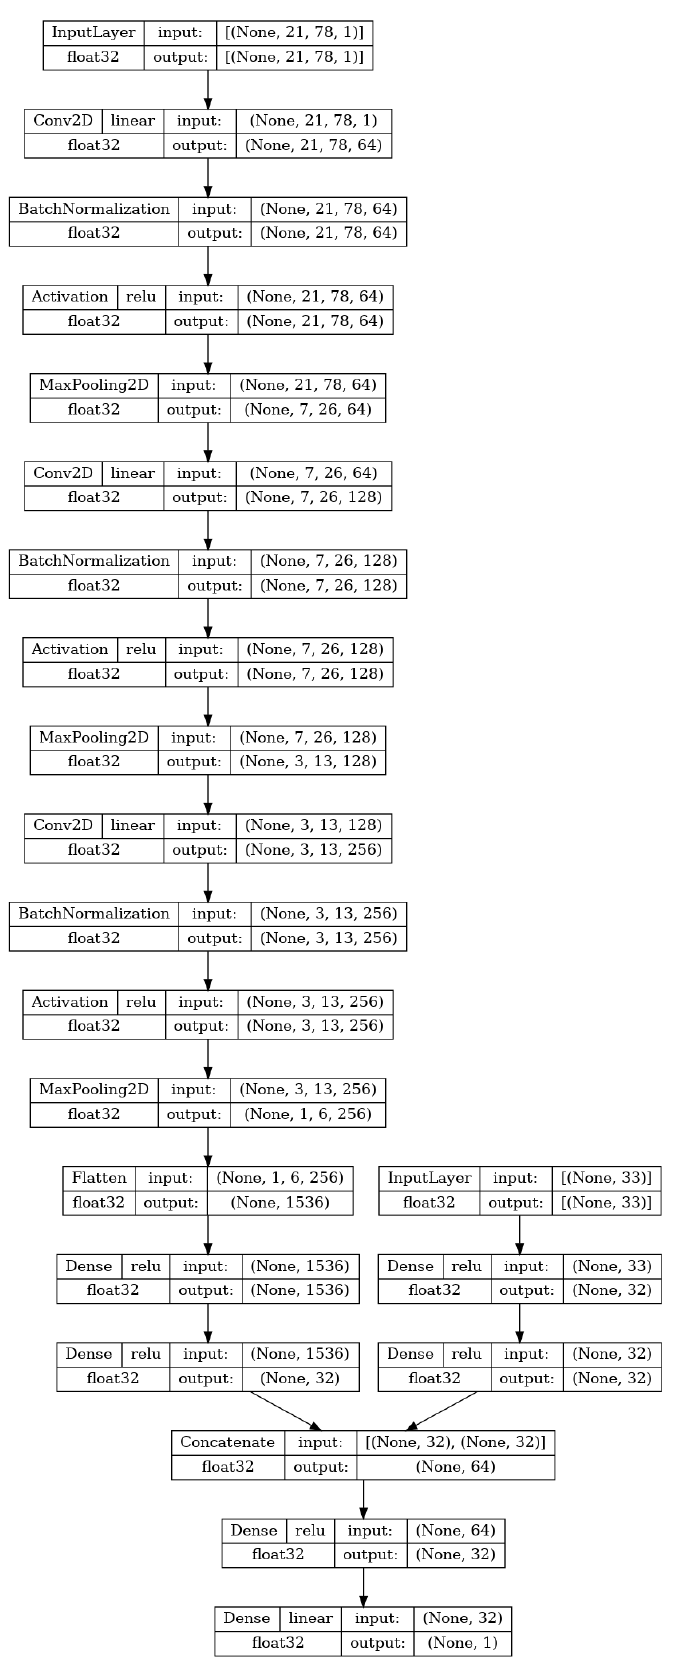
Figure 5. The regression CNN architecture combines the one-hot encoded SMILES and molecule